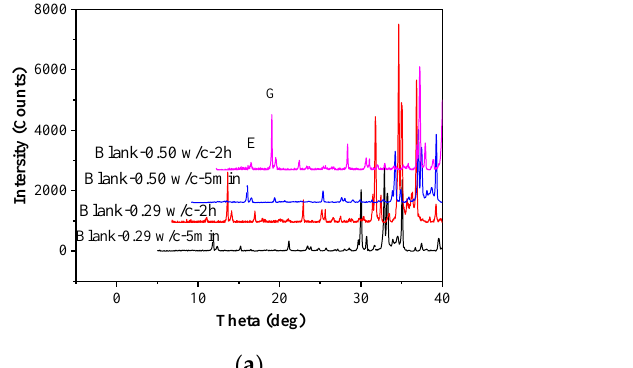
Figure 15. Bound water of samples at two w/c ratios (normalized to ignited mass): ( a ) w/c = 0.29 and ( b ) w/c = 0.50.